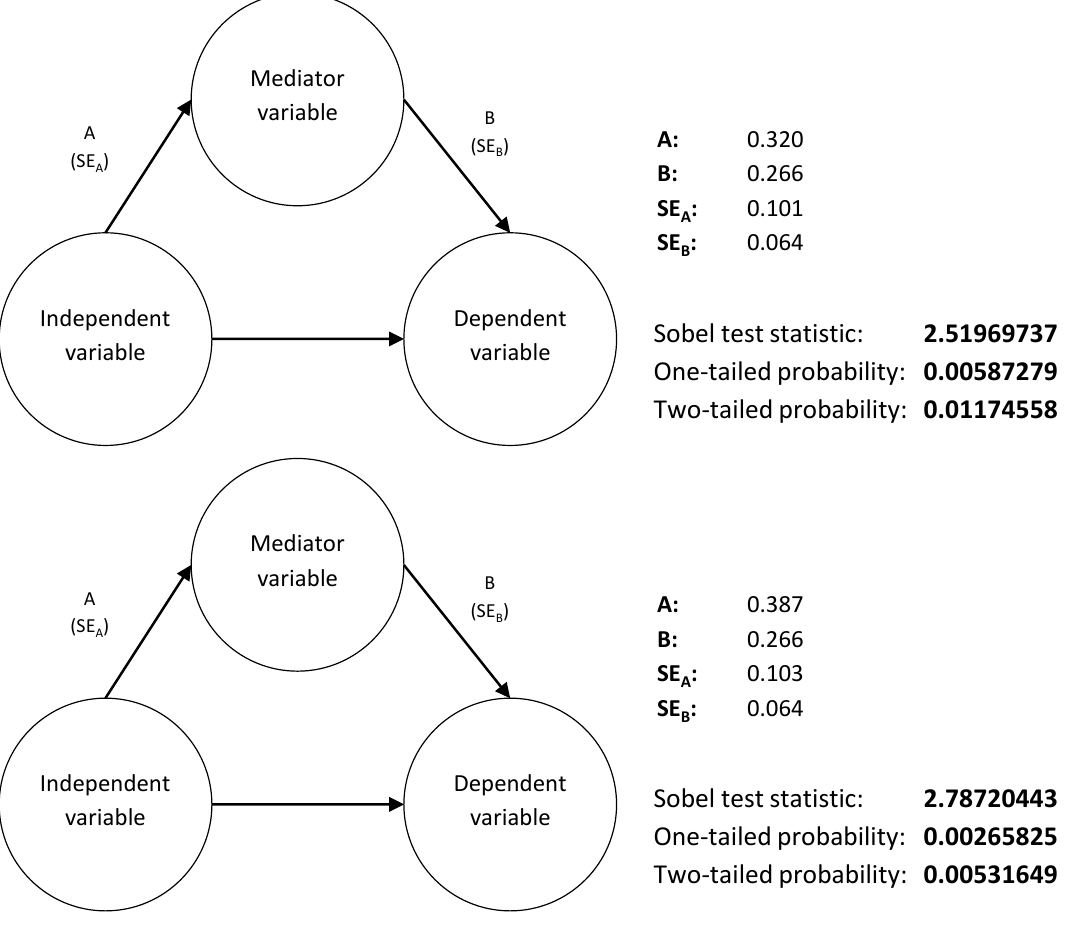
Figure 3. Result of Sobel